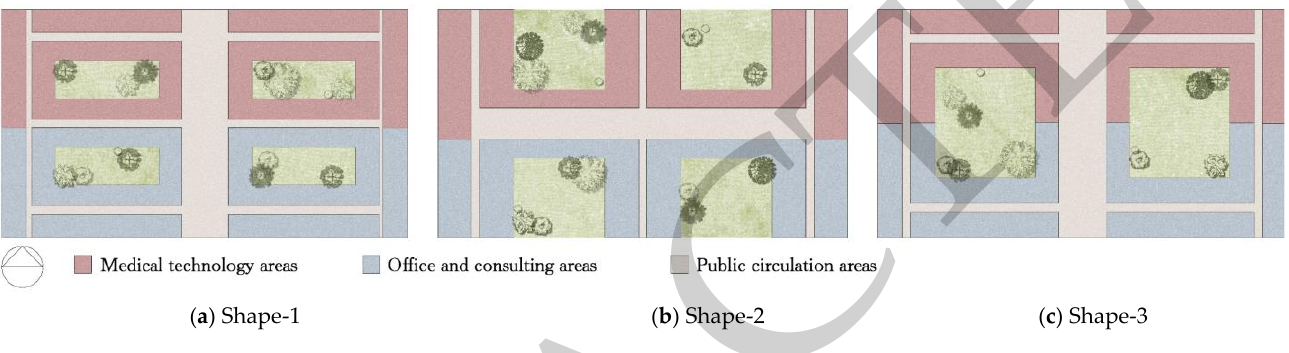
Figure 4. The plane layout of three typical models: ( a ) centralized-type; ( b ) corridor-type; and ( c ) courtyard-type.